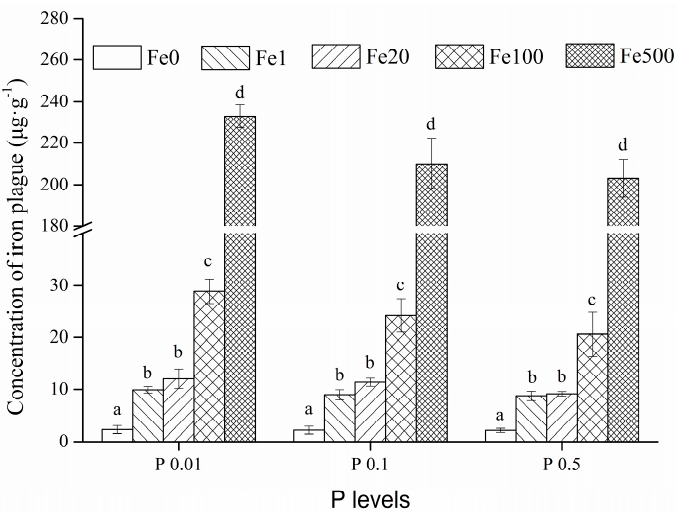
Figure 1. The amount of iron plaque on roots surface of G. spiculosa grown hydroponically with varying Fe 2+ concentrations and P levels. Values (mean ± SE, n = 3) followed by different letters designate significant differences ( p < 0.05) between Fe 2+ concentrations for a given P level (a, b, c, d). The data were square root transformed before statistical analysis.